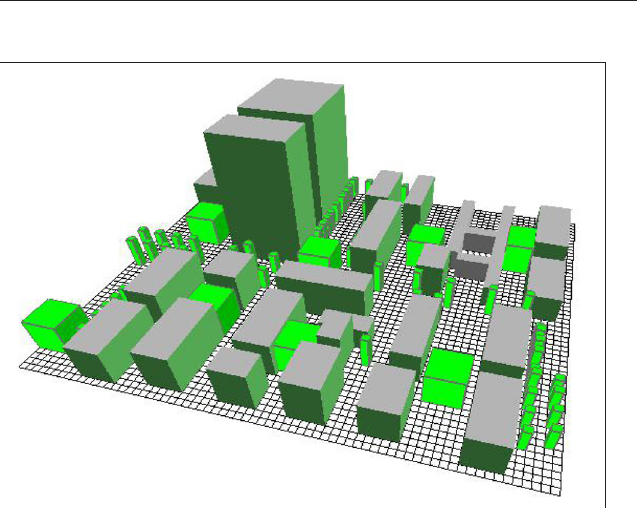
FIGURE 13 | Hourly changes in average 1 Ta and 1 RH of different vertical greening quantities in Chigang community (A) . PET frequency distribution in Chigang community with different vertical greening quantities (B) .